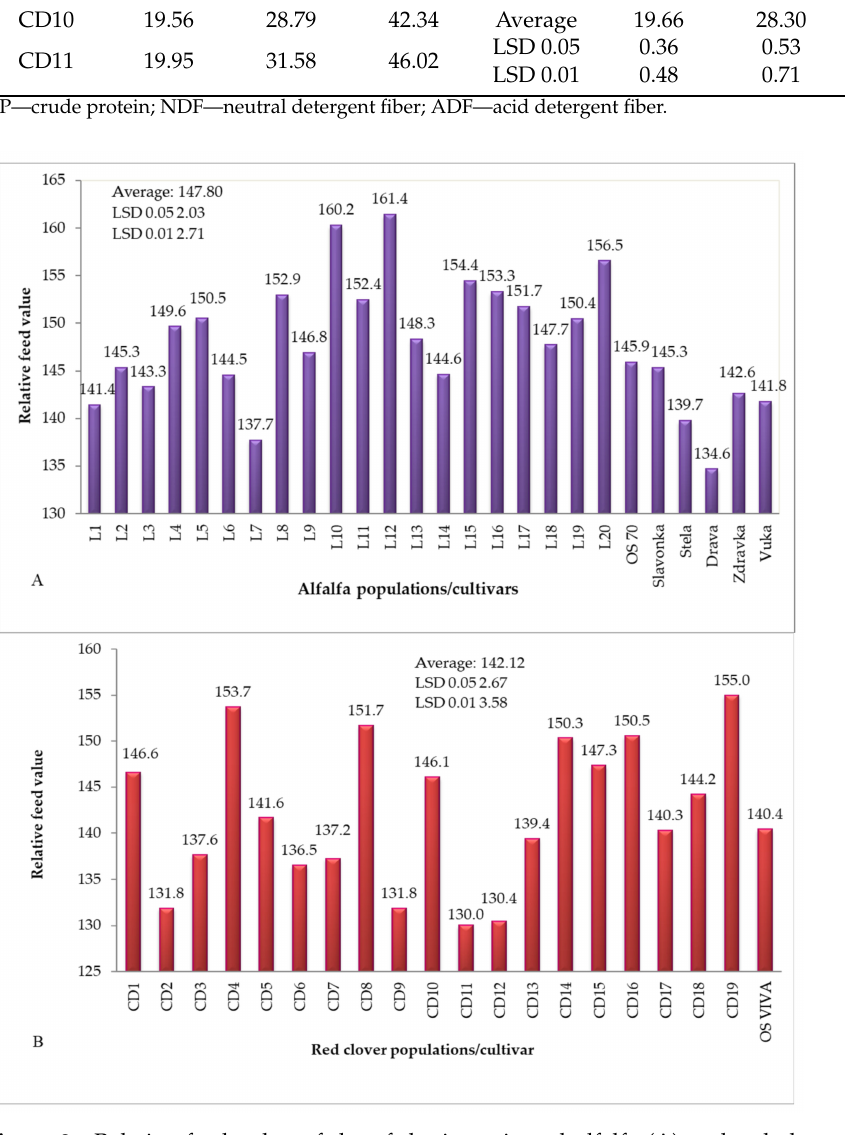
Table 3. Forage quality traits of the investigated red clover populations/cultivar in the second cut of the second growing season at the beginning of the flowering to full bloom stage. Red Quality Traits, %DM Clover